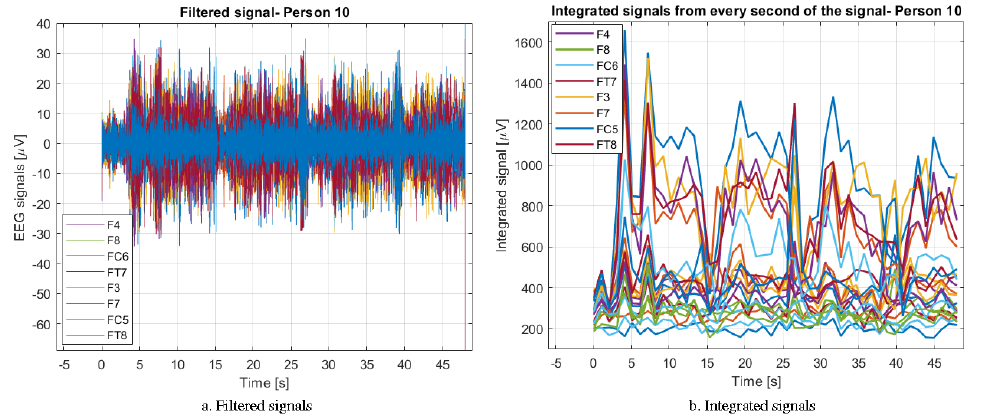
Figure 15. Comparison of filtered and integrated signals—Person 10.